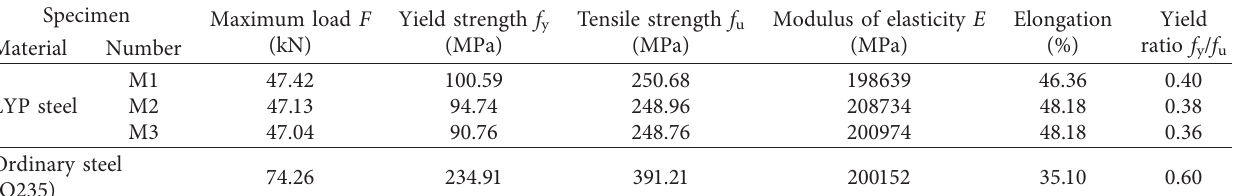
Table 2: Results of the material test.